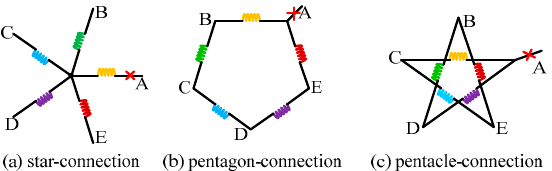
Figure 2. Graphical illustration for a single open-line fault.